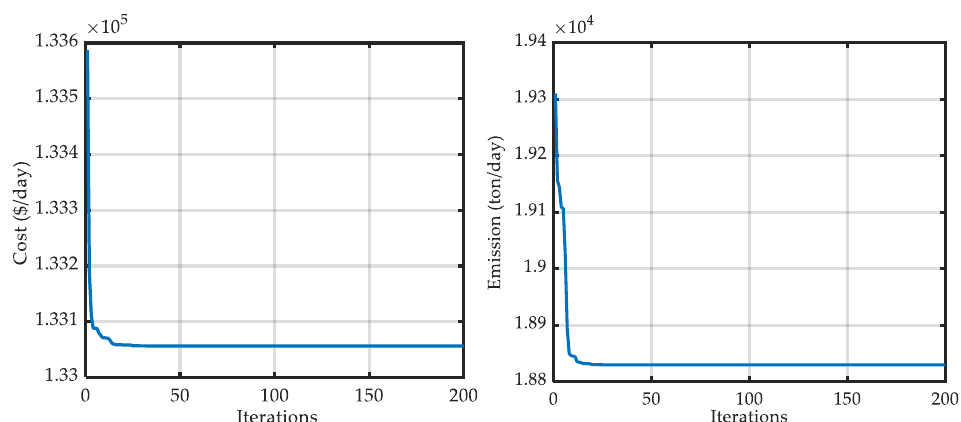
Figure 6. Convergence characteristics of the proposed method for case 1.